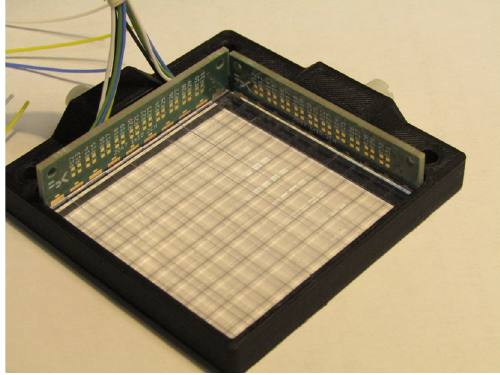
Fig. 20 Complete Δ E of the telescope, composed by two layers of orthogonal bars, read by 2 arrays of SiPMs